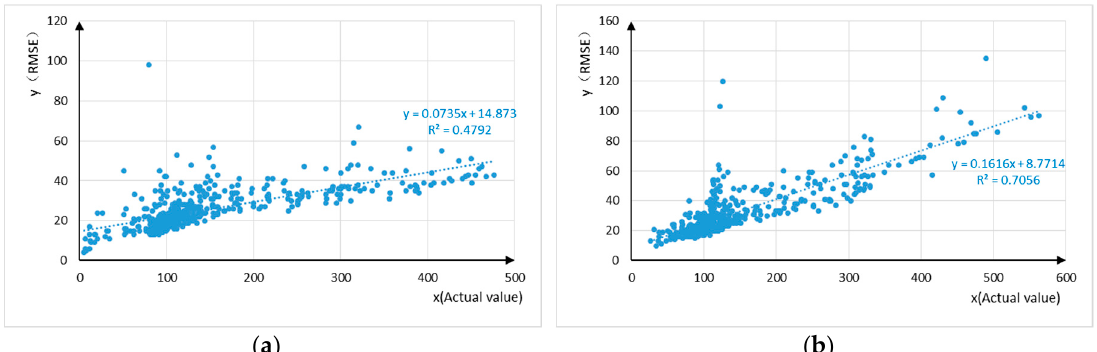
Figure 17. The relationship between the RMSE and TMAV for ( a ) passenger inflow volume and ( b ) passenger outflow volume, at each 10-min interval.